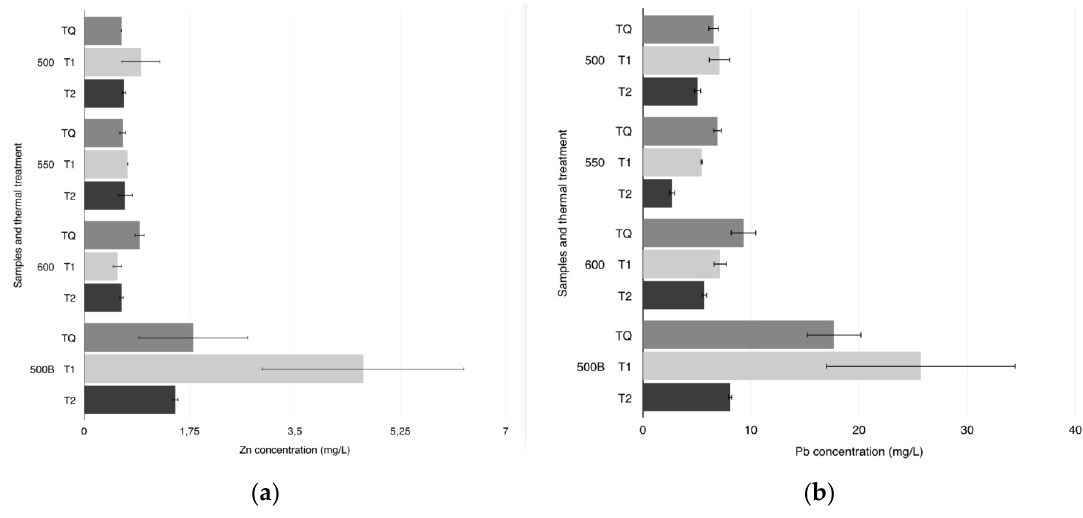
Figure 3. Concentration of Zn ( a ) and Pb ( b ) in the leaching solutions of the COSMOS ‐ RICE samples obtained by using the whole RHA samples (see Table 1).